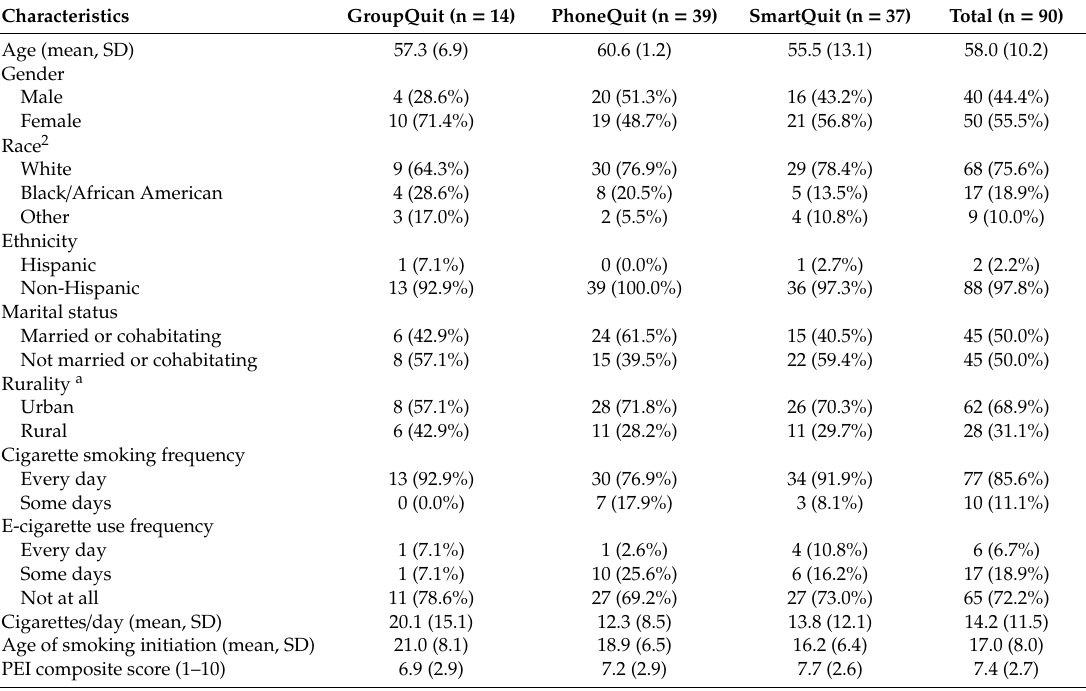
Table 1. Participant characteristics (n =